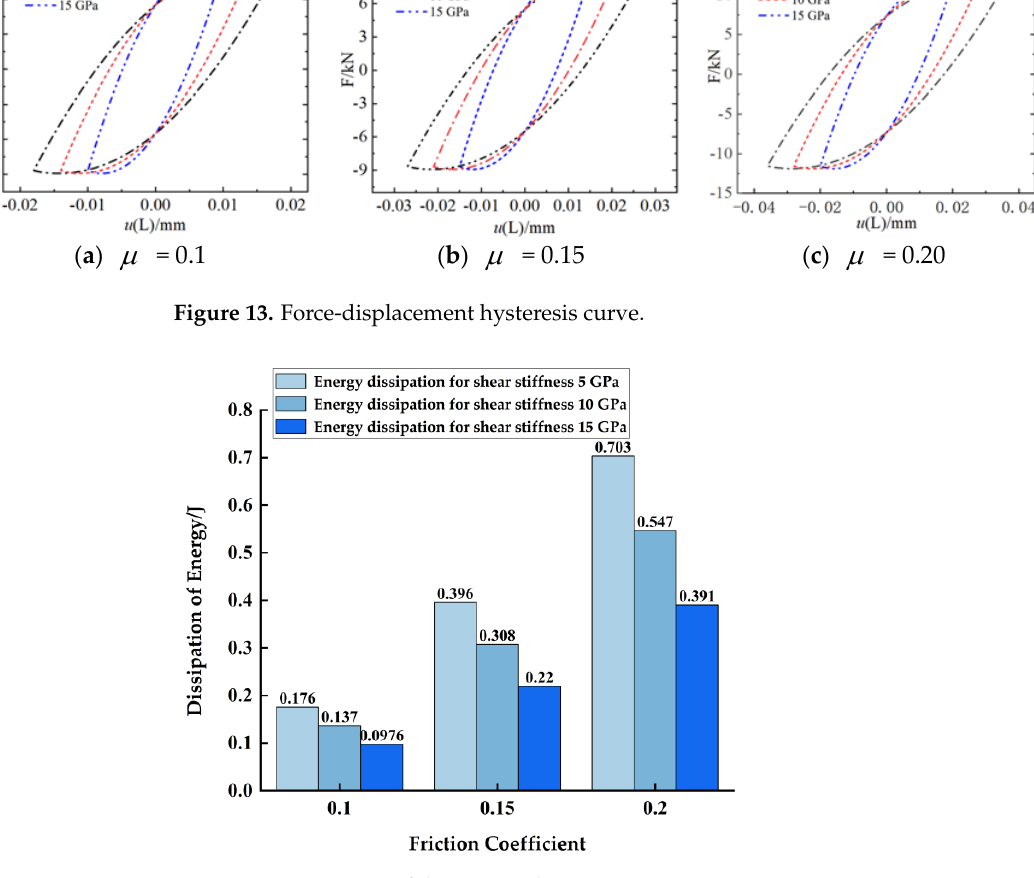
Figure 14. Histogram of the energy dissipation.